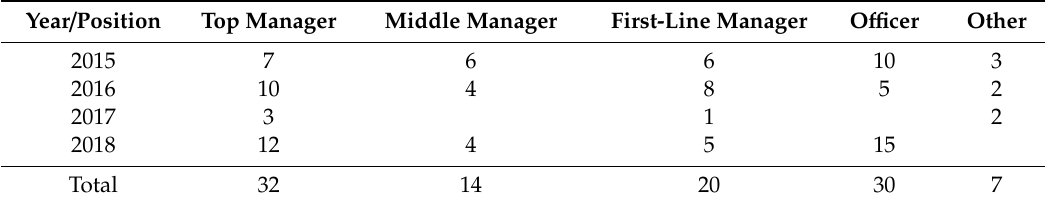
Table 1. A summary of